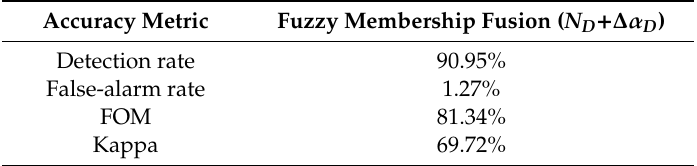
Figure 10. Determined fuzzy membership grades of each damage indicator ( a ) ∆ N D and ( b ) ∆ α D . The combined membership grade by ( c ) fuzzy membership fusion and ( d ) spatial contextual fusion. ( e ) The binary classification result from the contextual fusion. ( f ) Reference Google Earth optical image of the study area. Table 2. Detection accuracies of the fuzzy contextual classification result.